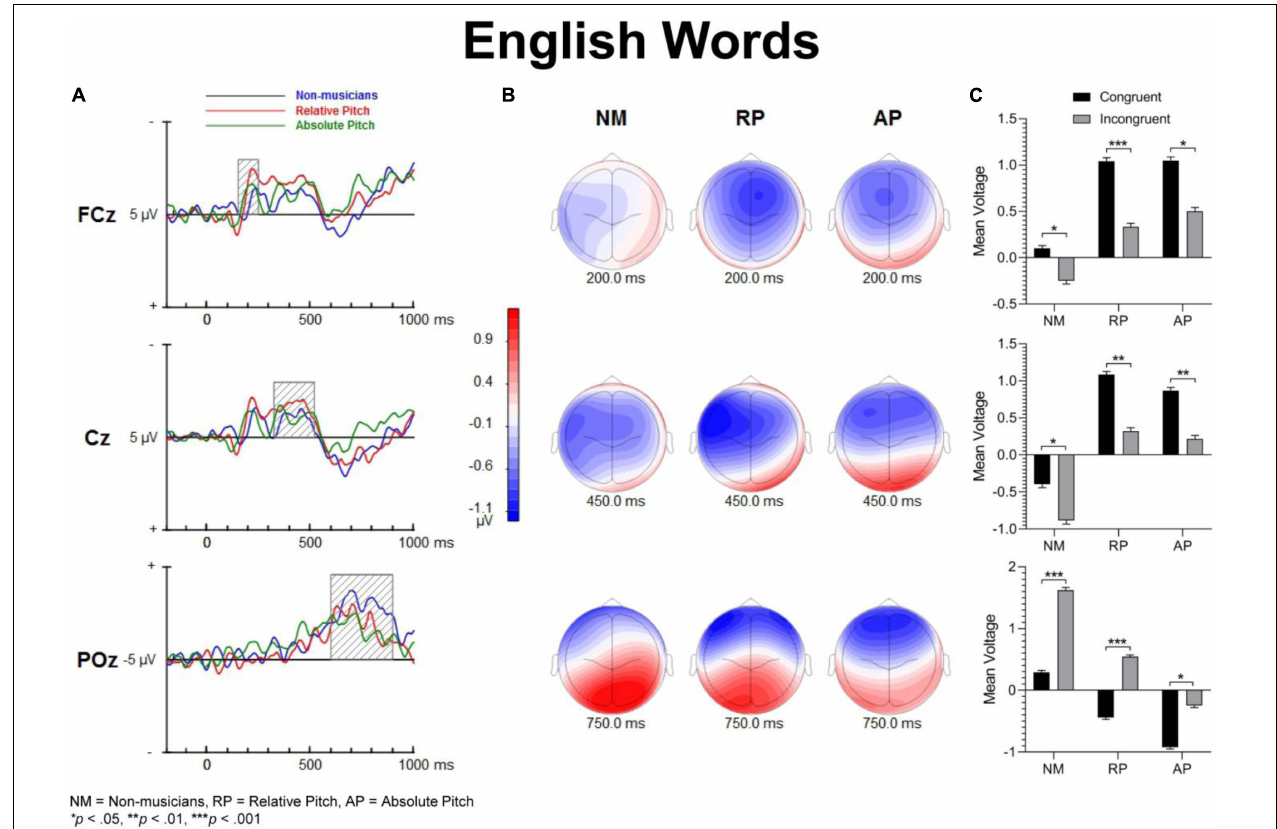
FIGURE 5 | Event-related potential difference waveforms of incongruent minus congruent conditions and topographic maps. (A) Difference waves forms and shaded areas displaying temporal windows of interest. (B) Topographic maps show fronto-central negativities at 200 and 450 ms along with a posterior positivity at 750 ms post-stimulation. (C) Bar graphs showing group mean event-related potential amplitude for the P200 (top panel), N450 (middle panel) and LPC (bottom panel).